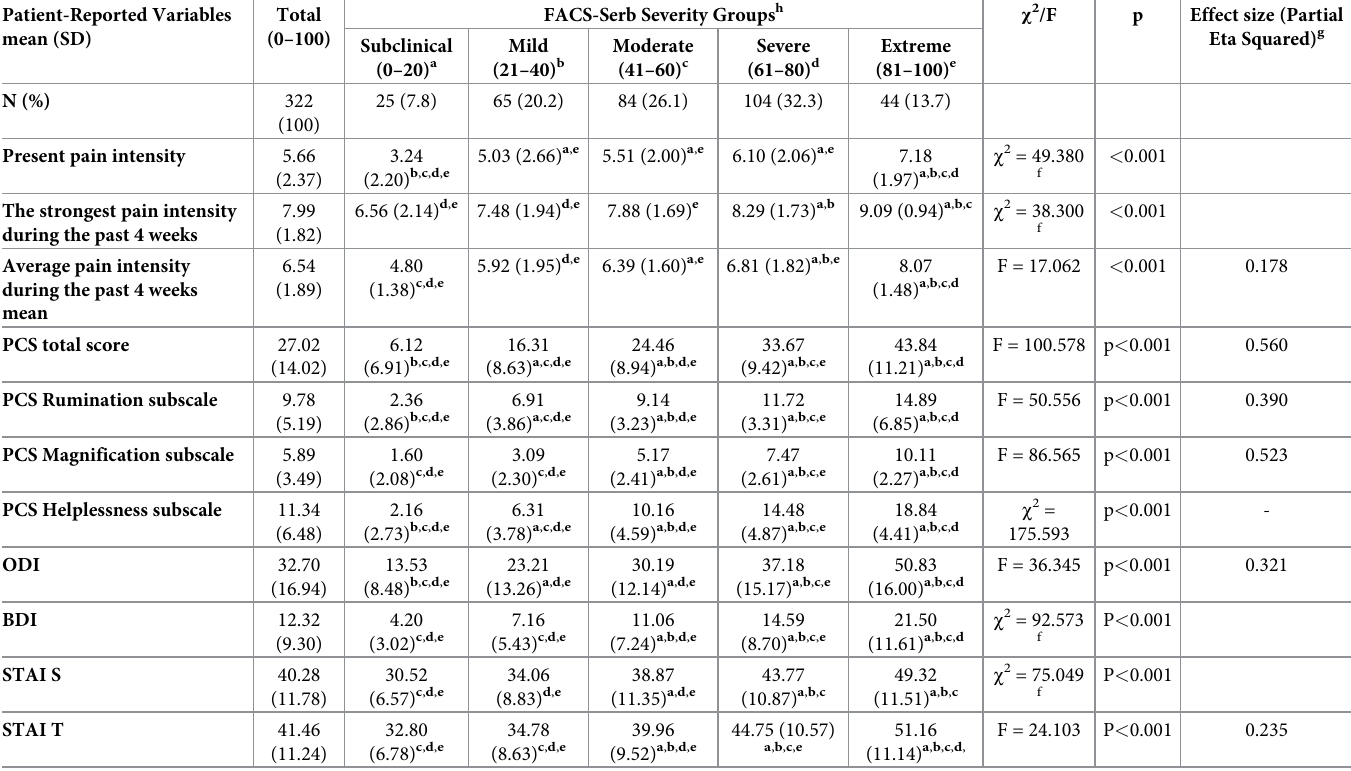
Table 2. Patient-reported clinical variables by FACS-Serb severity